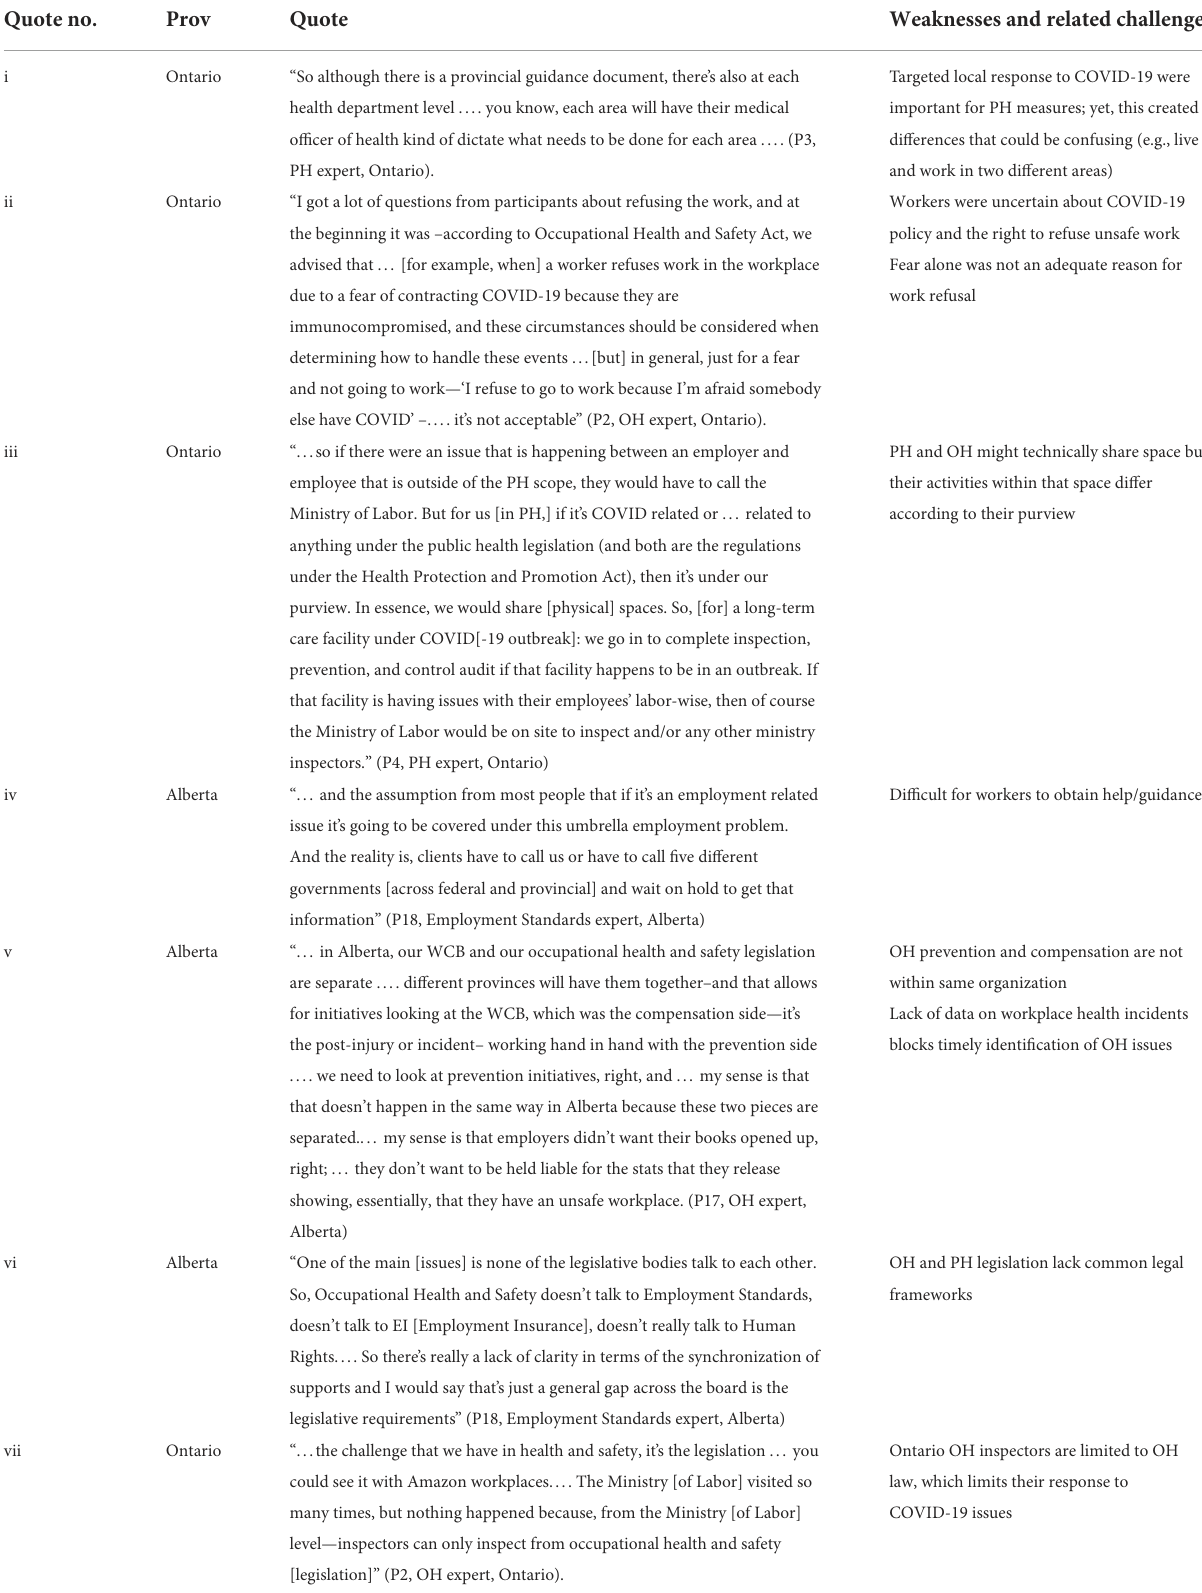
TABLE 4 Weaknesses: Key points identified from quotes about PH-OH pandemic response and KI province. Quote